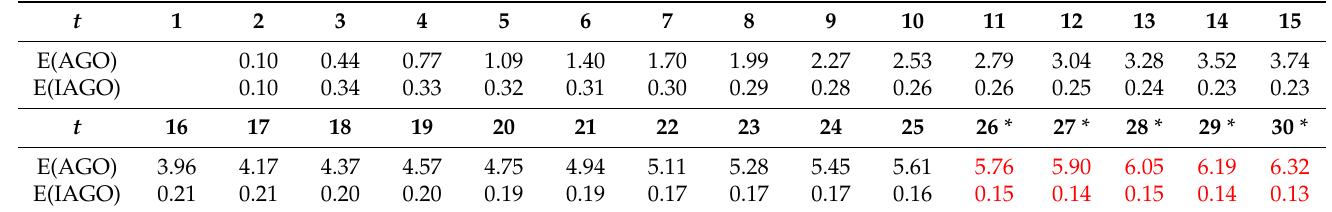
* red color indicates forecasted values.